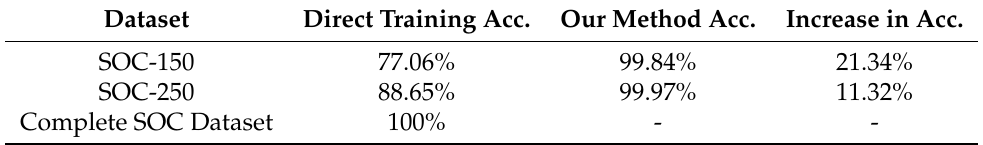
Table 5. SOC datasets experimental results.